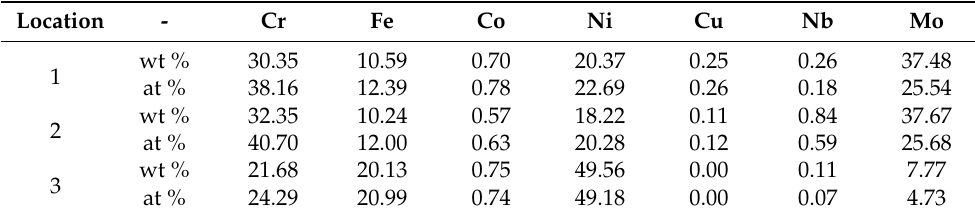
Table 1. EDS results of different locations marked in Figure 9.